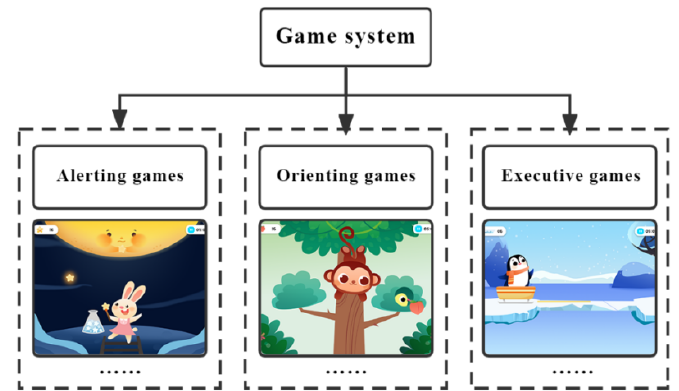
Figure 5. The structure of the game system (authors’ proposal).